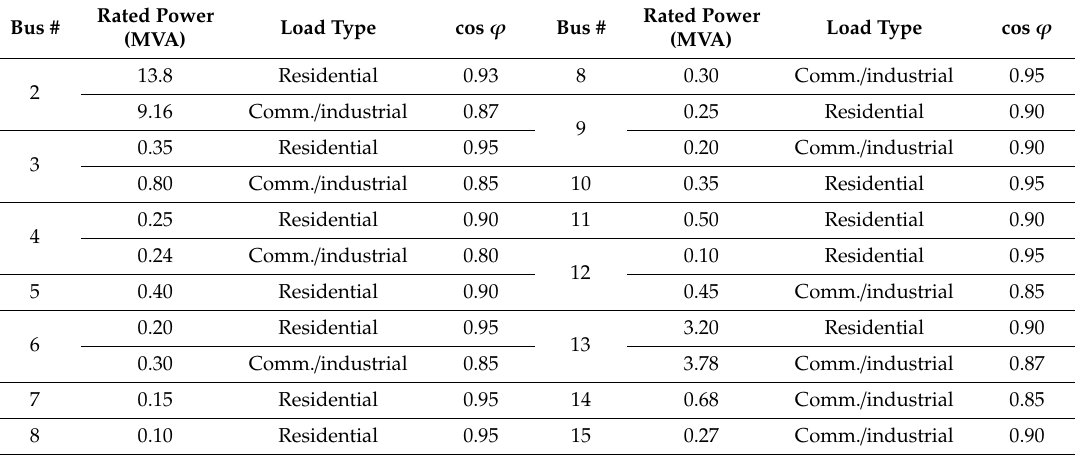
Table 2. Load Input data.